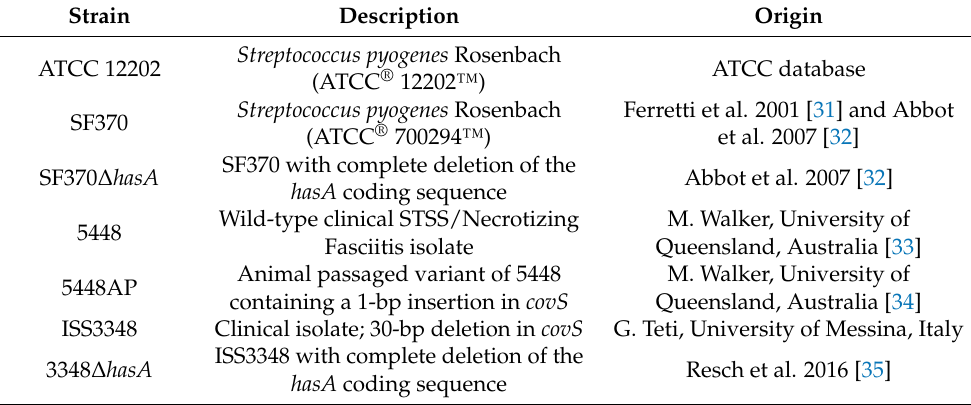
Table 1. S. pyogenes strains used in this